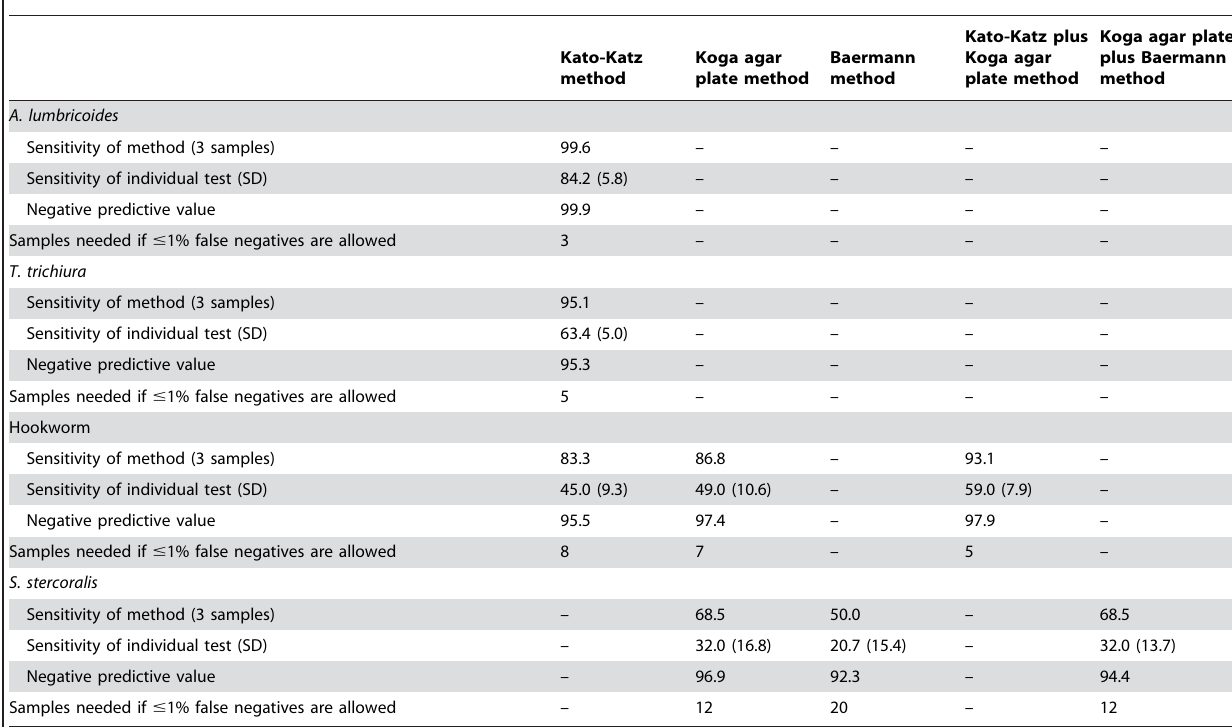
Table 2. Sensitivity of individual and combined diagnostic methods if 1 or 3 stool samples from children from Chaani and Kinyasini schools, Zanzibar, were examined (all values expressed as percentage, %) and samples needed to obtain # 1% false negative test